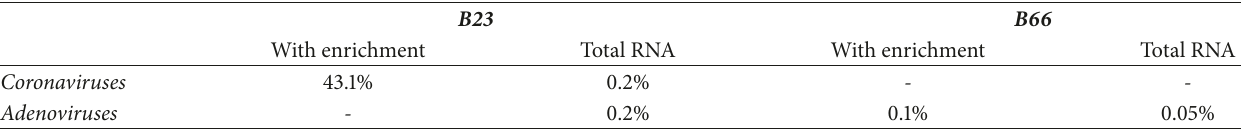
Table 4: Comparison of the sequencing results of two samples with and without preenrichment by the primer’s panel. In the latter case, the total number of reads was ∼ 4.5 million per